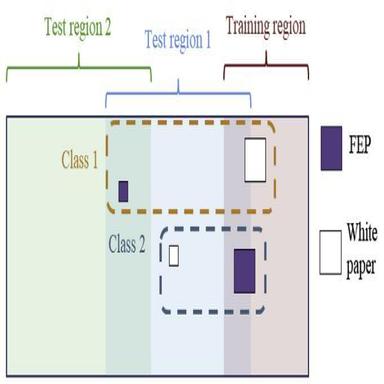
Sketch of the sample laminate, detailed in three different regions. Defects are represented by squares; the remaining area refers to sound material. Sizes are reported in scale.